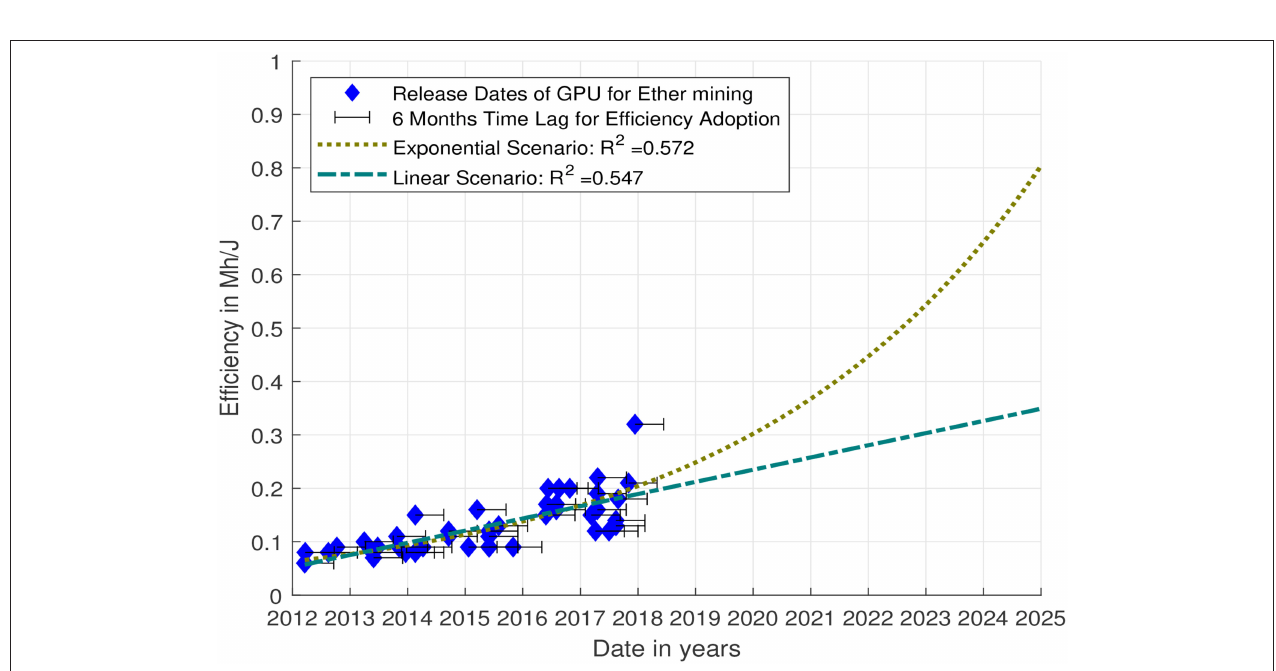
FIGURE 5 | Exponential and linear scenario for the development of the Ethereum hardware efficiency fitted to the past development. Data for the hardware release dates from Zade and Myklebost (2018).